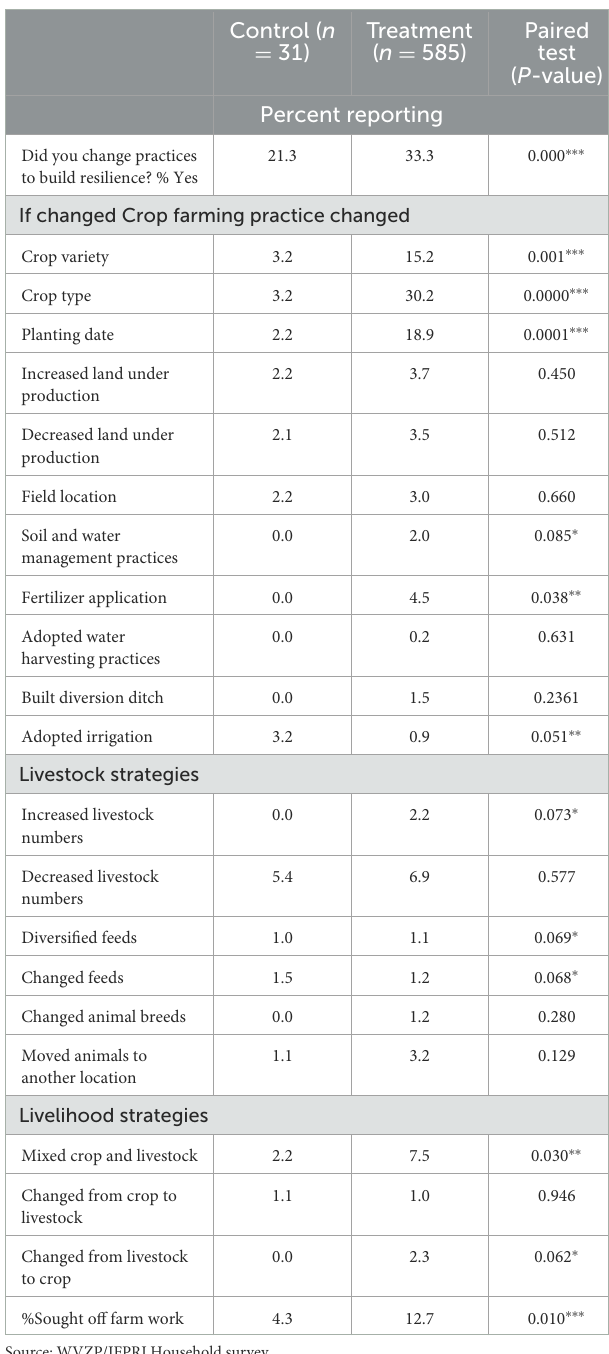
TABLE 6 Crop, livestock and livelihood strategies used to respond to last drought